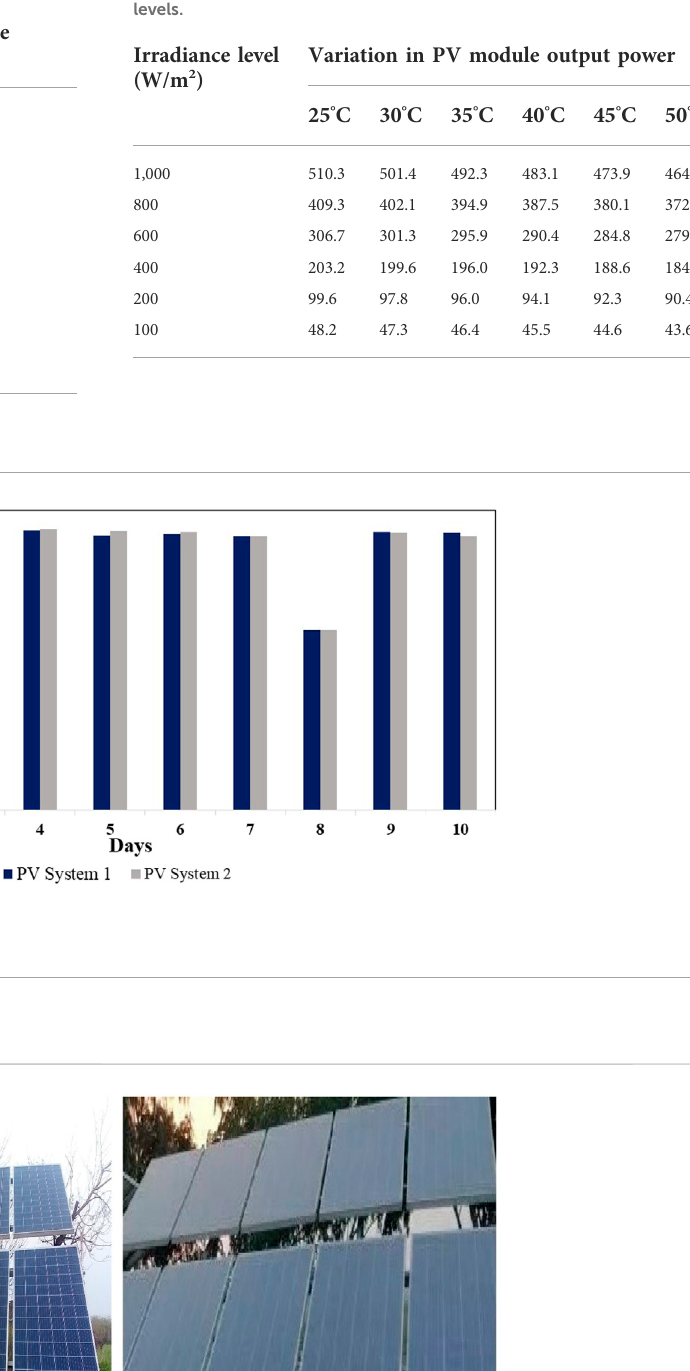
TABLE 5 Soiling loss impact on the PV system. TABLE 6 Power variation of the PV module at different temperature